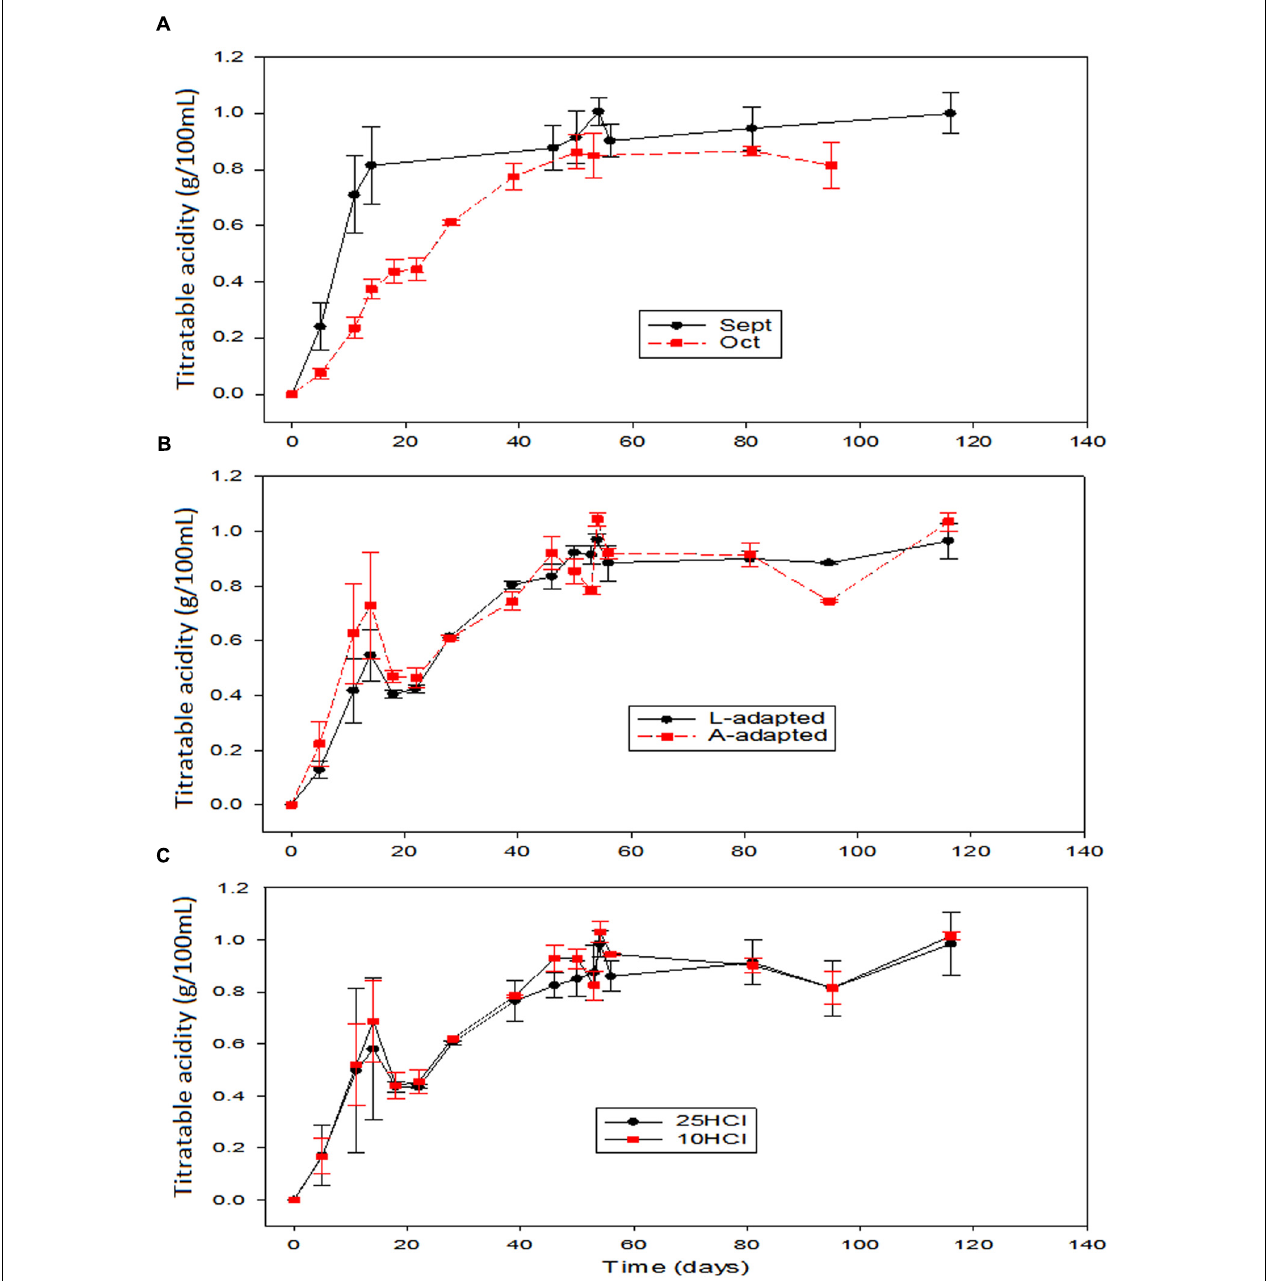
FIGURE 3 | Application of potential probiotic starter (LAB2) at industrial scale (season 2012/2013). Changes in titratable acidity ( ± CL, n = 4 for each level) according to time season (A) , type of inoculum (B) , and proportion of HCl added to fermentation vessels (C) . The values are always averages over the other two non-included in the graph variables. See Figure 1 for the the meanings of